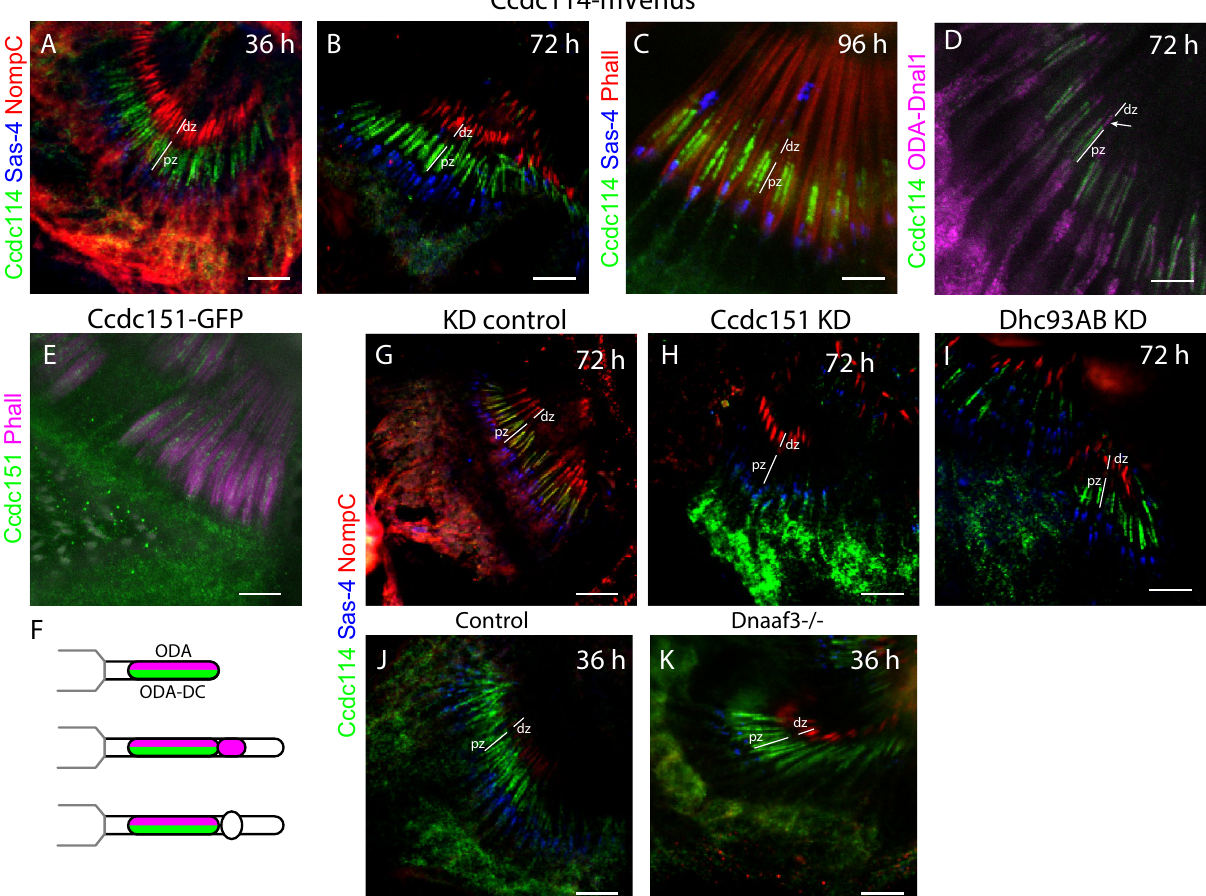
Figure 7. ODA-DC components localise directly to the proximal zone. ( A – C ) Pupal antennae at indicated hours, showing localisation of Ccdc114-mVenus to the proximal zone (pz) (distal zone also indicated, dz). Ccdc114-mVenus (green), Sas-4 (blue), NompC (red, A , B ) or phalloidin (red, C ). ( D ) Colocalisation of Ccdc114-mVenus (green) and ODA-Dnal1-mCherry (magenta) confirms colocalization in the proximal zone but only ODA-Dnal1-mCherry localises beyond (arrow). ( E ) Ccdc151-GFP (green) localises to cilia at 72 h; phalloidin (red). ( F ) Schematic summary of ODA-DC and ODA localisation. ( G – K ) Pupal antenna showing Ccdc114 (green), Sas-4 (blue), NompC (red). ( G , H ) Knockdown of Ccdc151 ( scaGal4 , UAS- Ccdc151 -RNAi) results in loss of Ccdc114 from the cilia ( H ) compared with control ( scaGal4 , KK control) ( G ). ( I ) Knockdown of Dhc93AB ( scaGal4 , UAS- Dhc93AB -RNAi) does not affect Ccdc114 in the cilia. ( J , K ) Ccdc114 is localised normally in Dnaaf3 homozygous mutant antennae ( K ) compared with control ( J ). All scale bars are 5